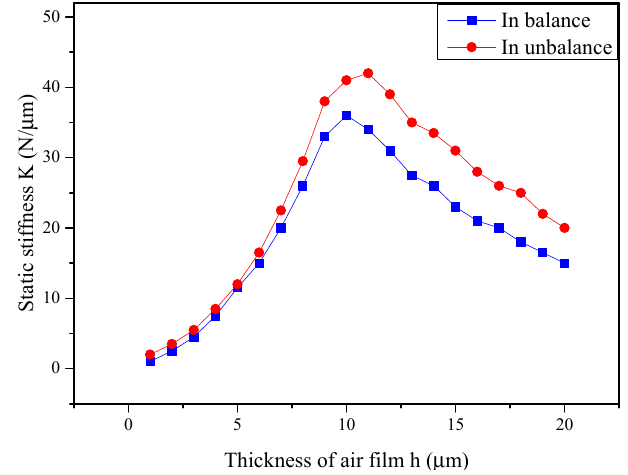
Figure 14. Variation curves of the static stiffness with the thickness of air films. To verify the accuracy of the simulation, the bearing capacity experiments were performed on an aerostatic guideway. The variations in air film thickness and load forces were measured through tests. In this experiment, an eddy current sensor was used to collect data on the micrometric displacement, and the sensor resolution was 0.02 µ m. As an external load, the weight reflects the bearing capacity of the cableless aerostatic